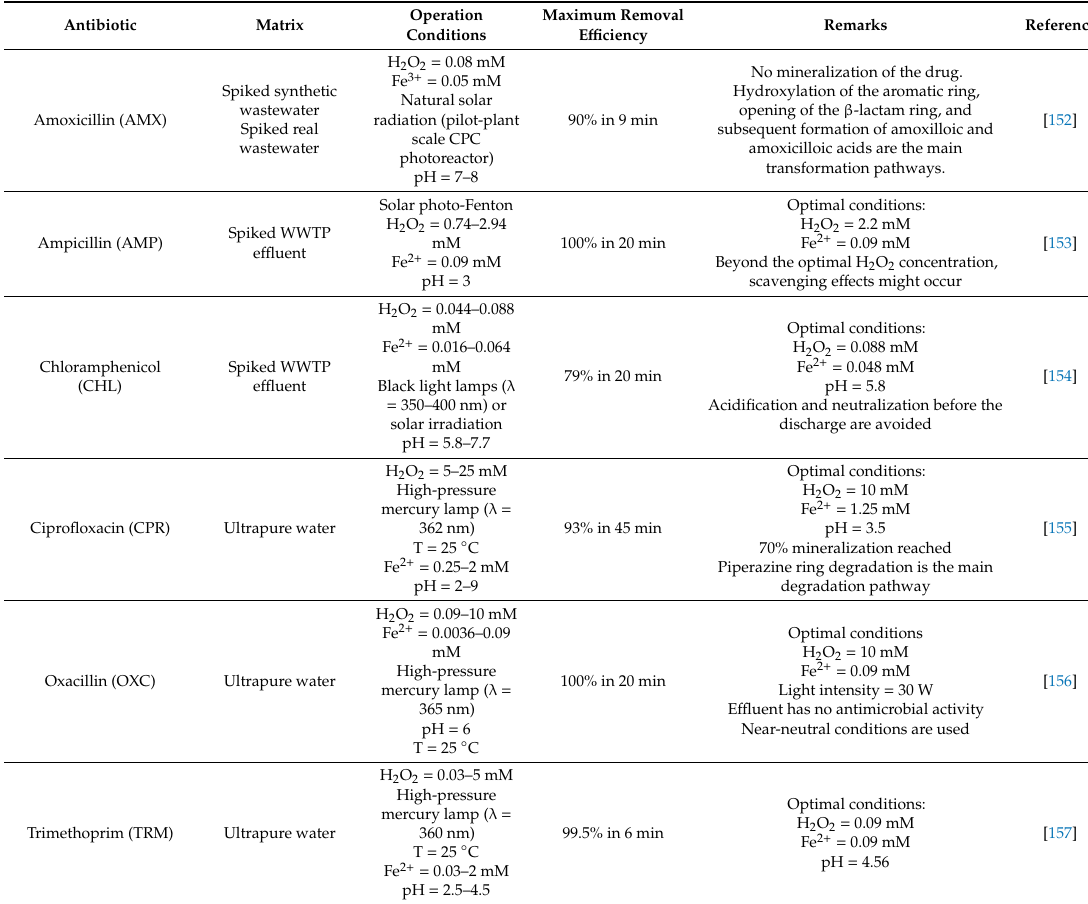
Table 12. Removal e ffi ciency of antibiotics in waters by photo-Fenton processes.